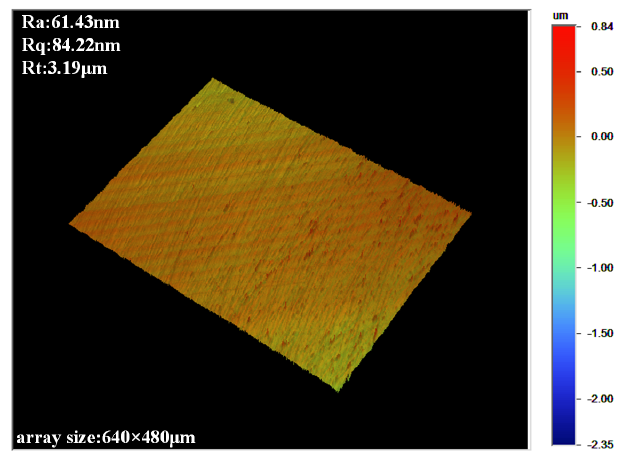
Figure 15. Surface topography of 316L stainless steel sample under the optimum process parameters.